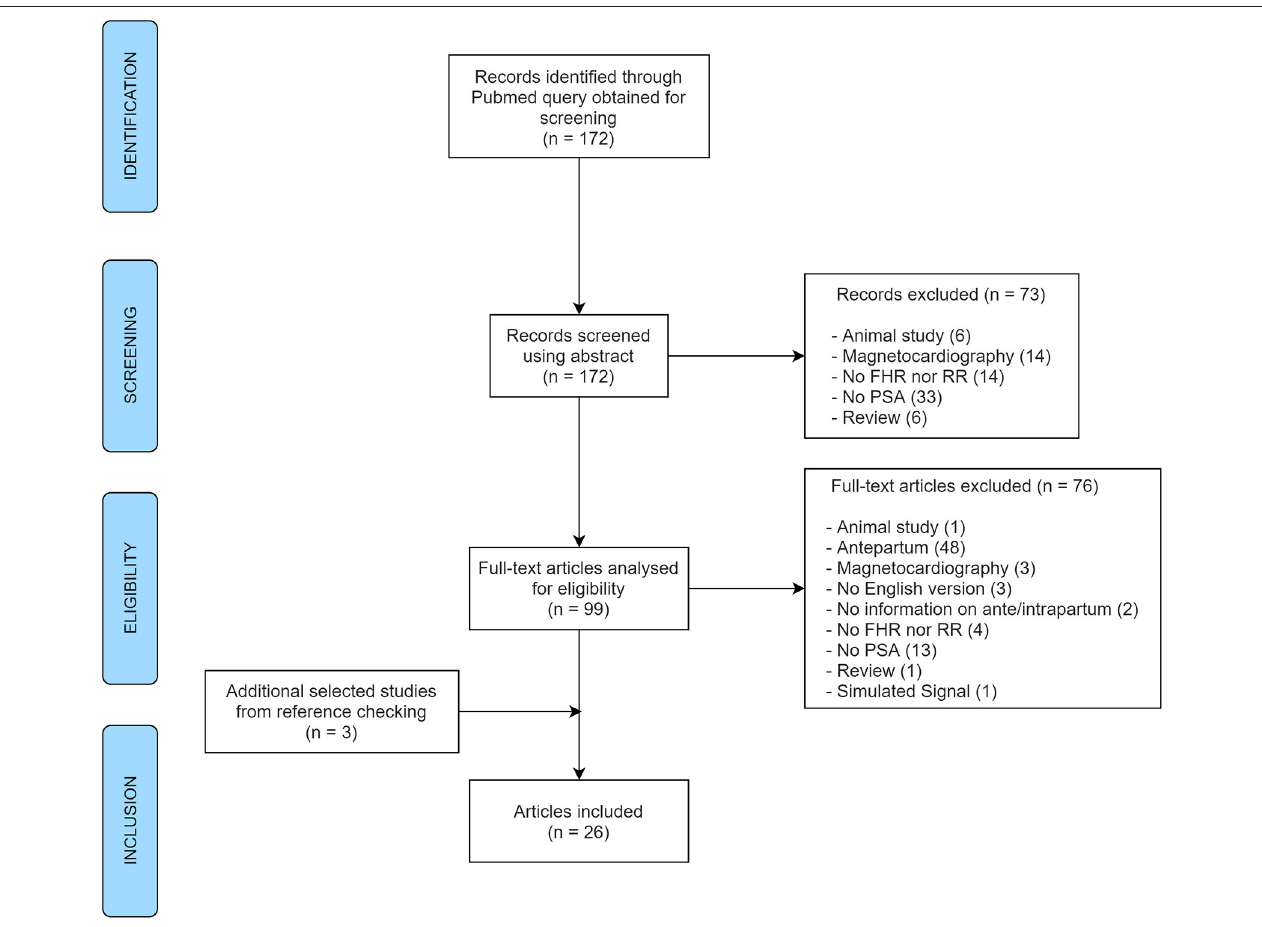
FIGURE 1 | PRISMA flow diagram of the article selection process for the systematic review (FHR, fetal heart rate; RR, interval between R peaks; PSA, power spectral analysis).